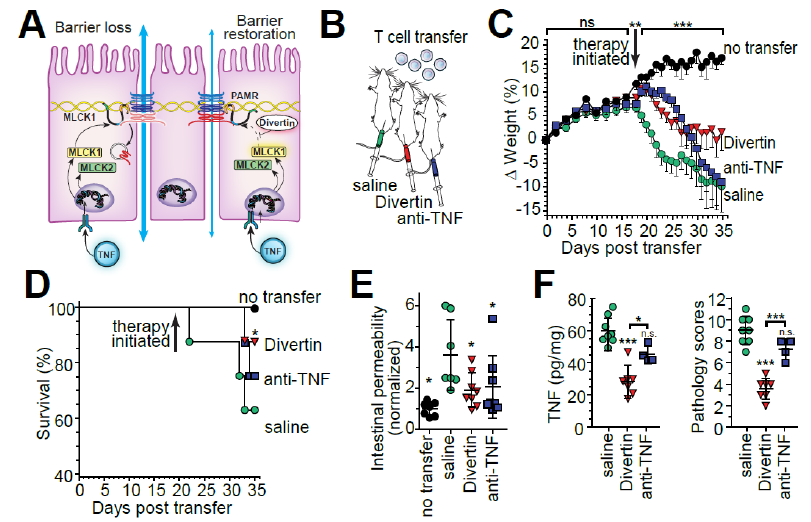
Figure 4. Inhibition of MLCK1 recruitment to the perijunctional actomyosin ring attenuates immune-mediated colitis. ( A ) Proposed mechanism of Divertin action. ( B ) Immunodeficient mice received naïve CD4+ effector T cells. Therapy with saline (vehicle), divertin, anti-TNF, or combined Divertin and anti-TNF was initiated after definitive features of disease developed (day 19). ( C ) Divertin limited weight loss after T cell transfer and was superior to anti-TNF antibody treatment. ** p < 0.01 by two-